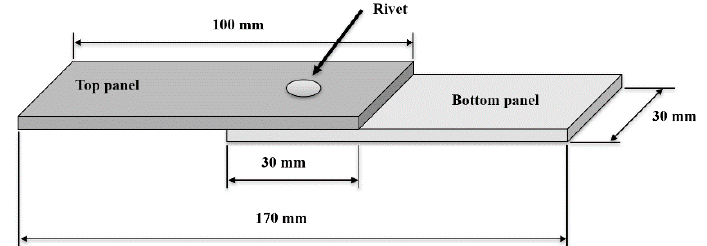
Figure 5. The dimensions of the test sample used for the tensile-shear test (KS B ISO 14273).